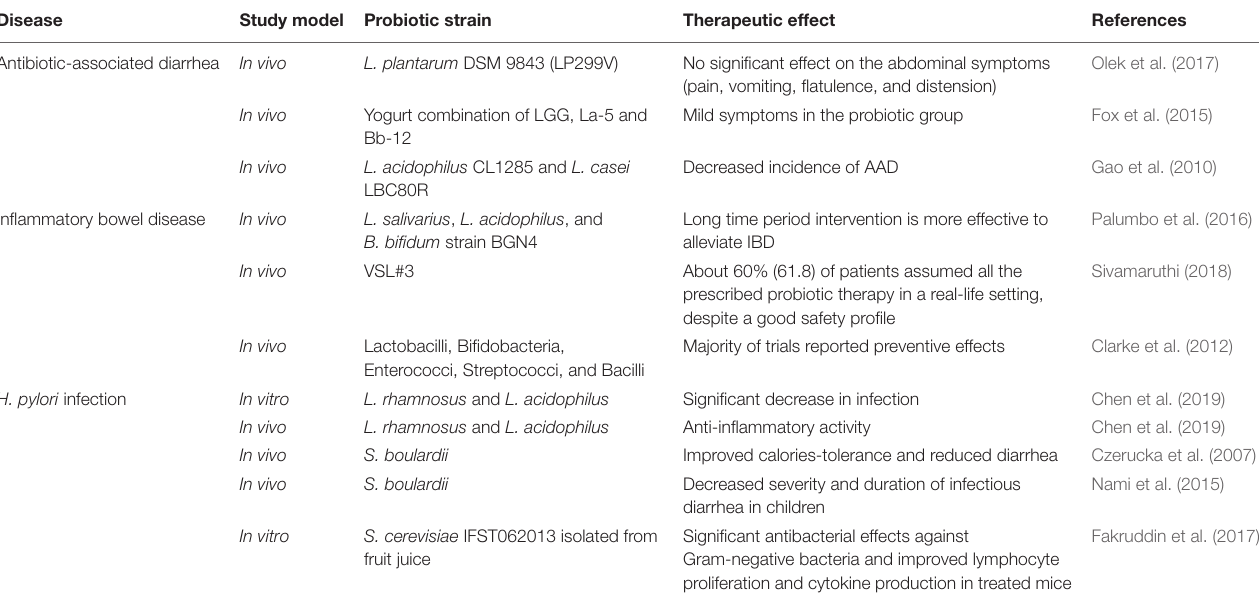
TABLE 2 | In vitro and in vivo effect of probiotics against gastrointestinal tract (GIT)